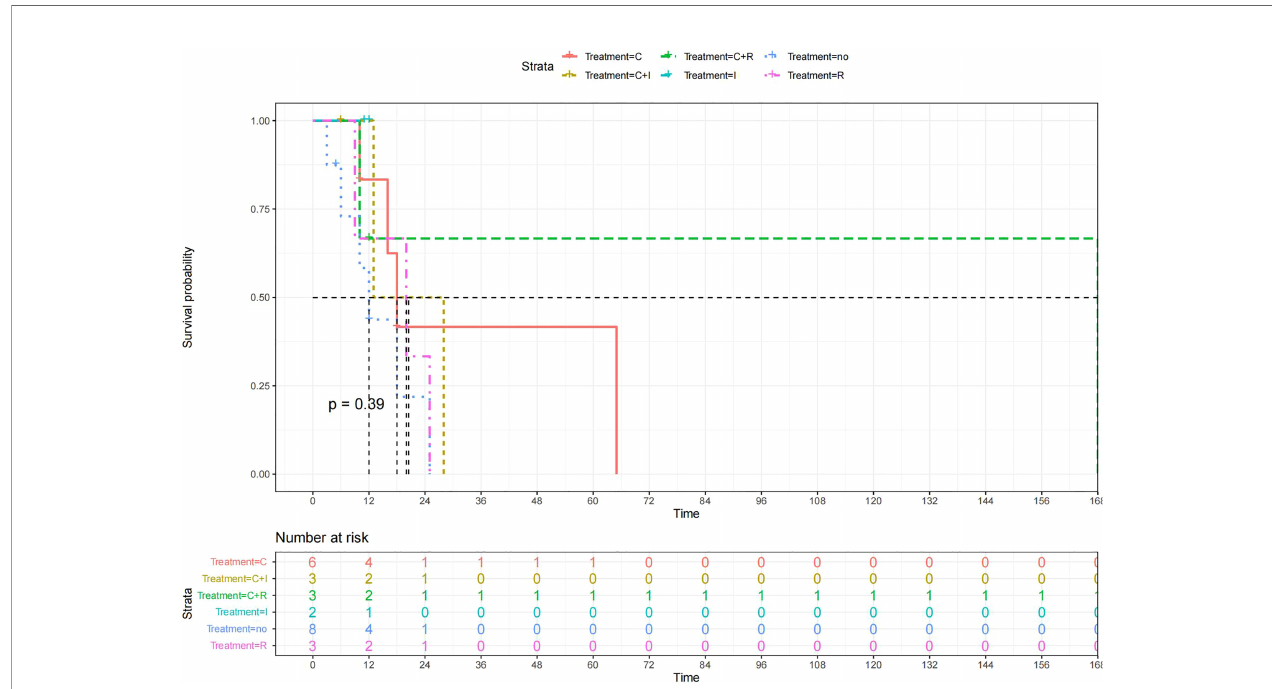
FIGURE 12 | Kaplan-Meier survival curves for OS in patients of TAH-based surgery plus various treatments vs. no other treatments. The median OS was signi fi cantly longer for patients who added chemotherapy+radiotherapy than for those who added the remaining treatment modalities C:chemotherapy R:radiotherapy I: immunotherapy(interferon- g or interleukin-2) PD : PD-1/PD-L1 Others:oncolytic virus Rigvir ® ,argon laser,Argon heliumknife+Sunitinib no:no other treatment.